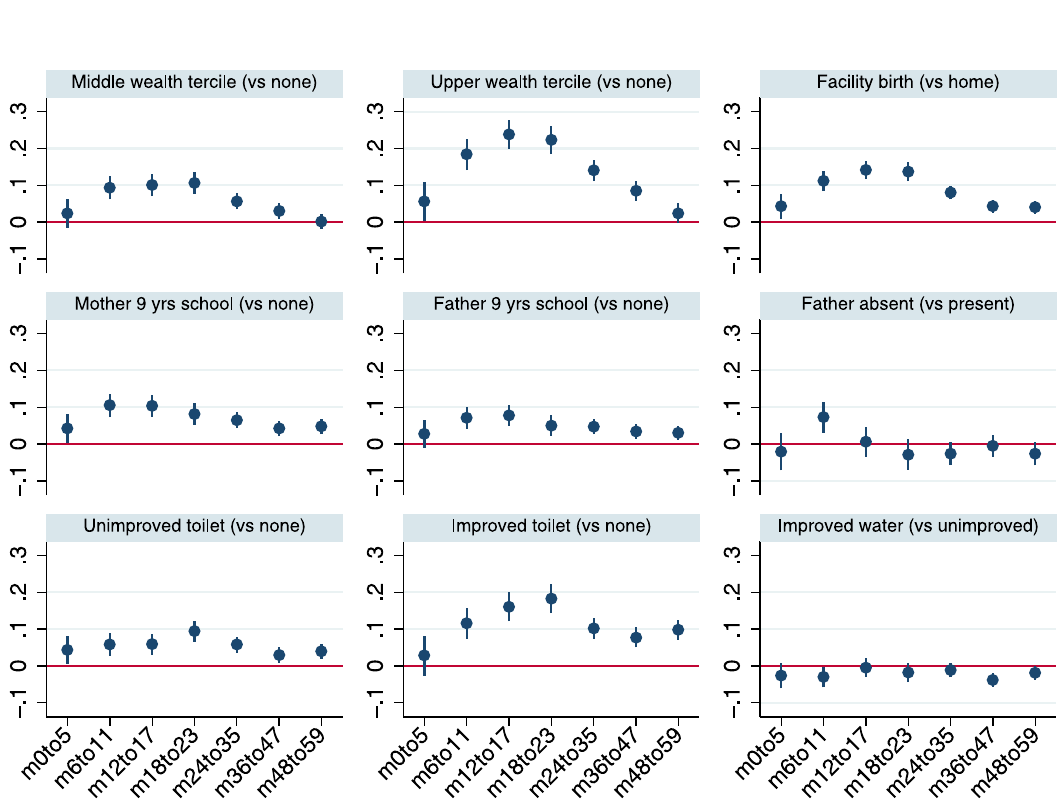
Fig 5. Least squares estimates for WHZ scores by age-restricted sub-samples: Household wealth, health facility access, parental education, household sanitation and water variables. Notes: The figure reports coefficients and 95% confidence intervals based on cluster-adjusted standard errors from multivariable least squares regressions of HAZ against all the variables listed in Table 1, as well as country-year fixed effects and dummy variables for every month of child age. Samples sizes for the regressions estimated for the various age groups are 67,384 (0–5 months; m0to5 ),75,965 (6–11 months; m6to11 ),76,711 (12–17 months; m12to17 ), 68,694 (18–23 months; m18to23 ),129,174 (24–35 months; m24-35 ),138,342 (36–47 months; m36to47 ), 132,242 (48–59 months; m48to59 ).